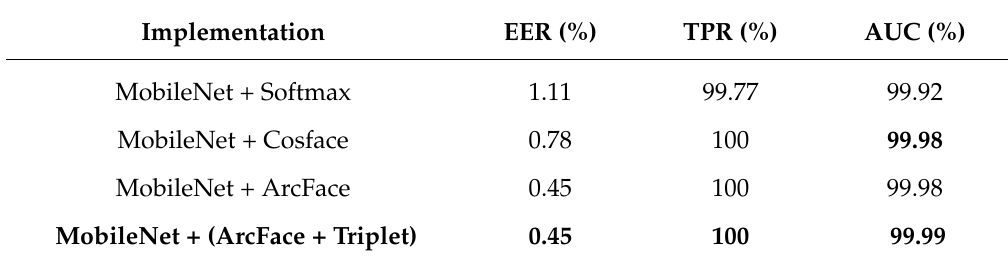
Table 2. Testing results of different implementation on IIT Delhi.